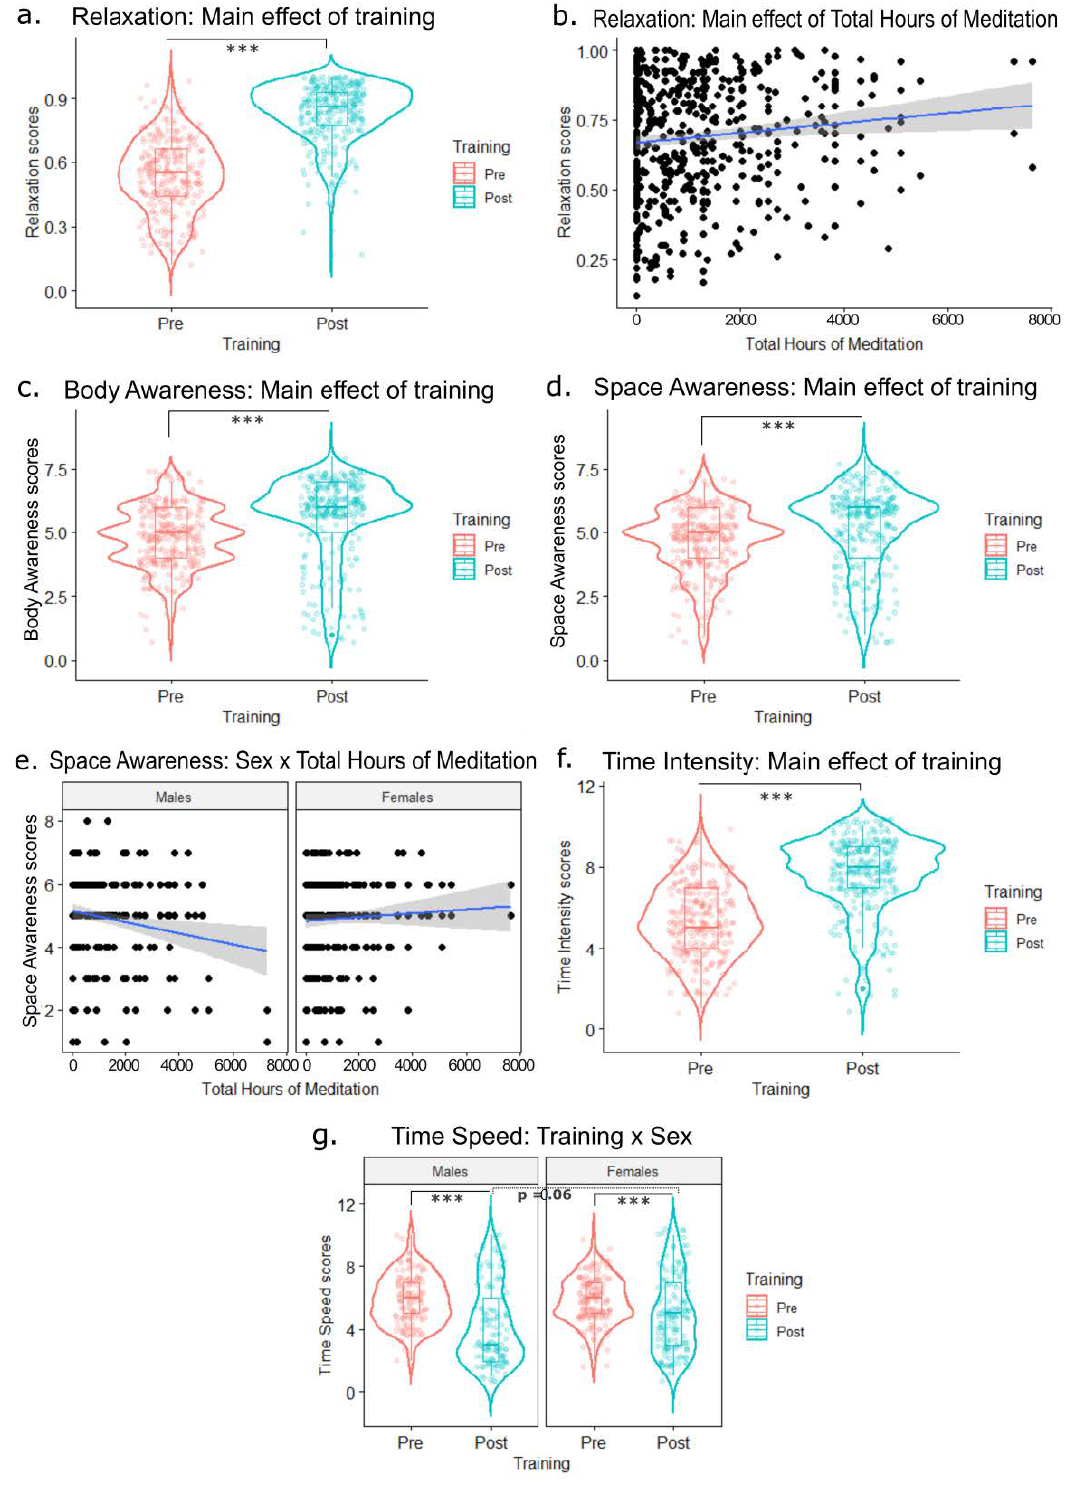
Figure 4. ( a ) Main effect of training (pre vs. post) on relaxation scores. ( b ) Main effect of total meditation hours (covariate) on relaxation scores. ( c ) Main effect of training (pre vs. post) on body awareness scores. ( d ) Main effect of training (pre vs. post) on space awareness scores. ( e ) Interaction of sex (males vs. females) x total meditation hours on space awareness scores. ( f ) Main effect of training (pre vs. post) on time intensity scores. ( g ) Interaction of training (pre vs. post) × sex (males vs. females) on body awareness scores. *** = p <